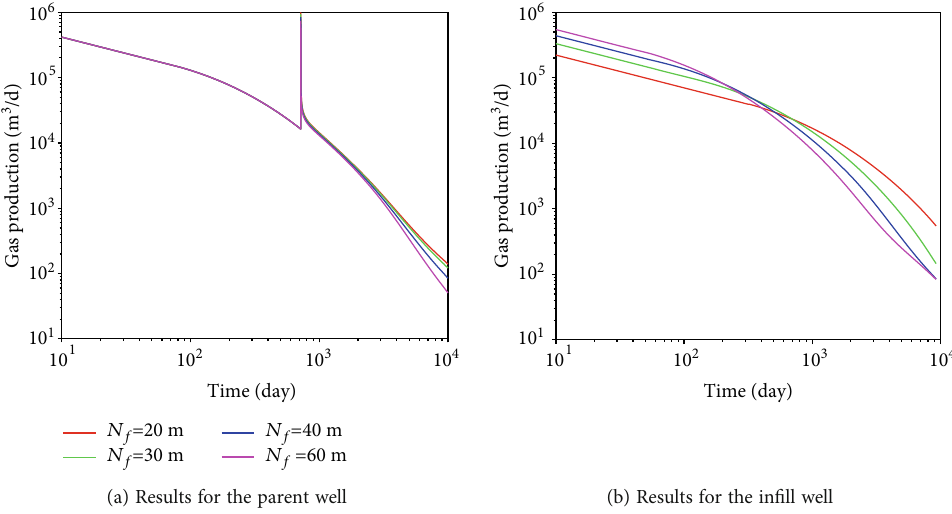
Figure 8: The e ff ects of fracture stages/clusters on the gas production of both parent and in fi ll